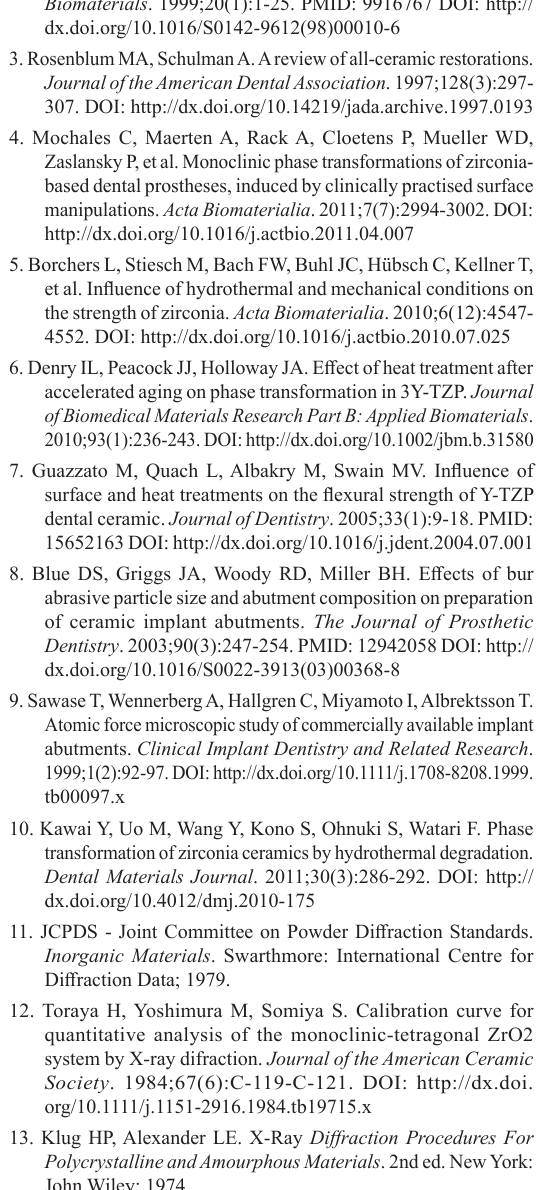
) as function of M